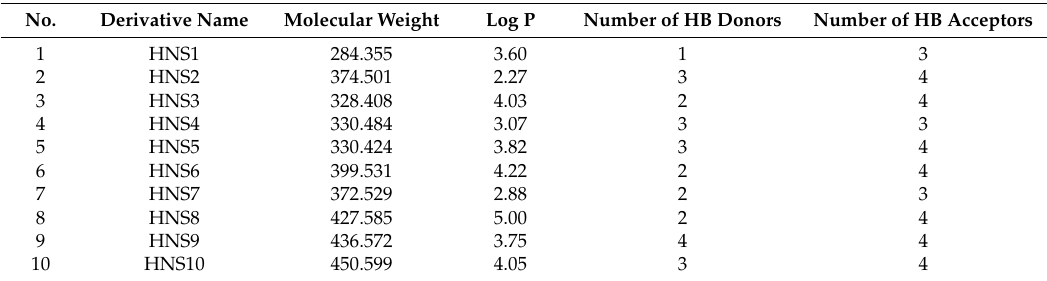
Table 2. Computed standard properties of ChalcEA derivatives based on Lipinski’s Rule of Five. HB indicates hydrogen bond.